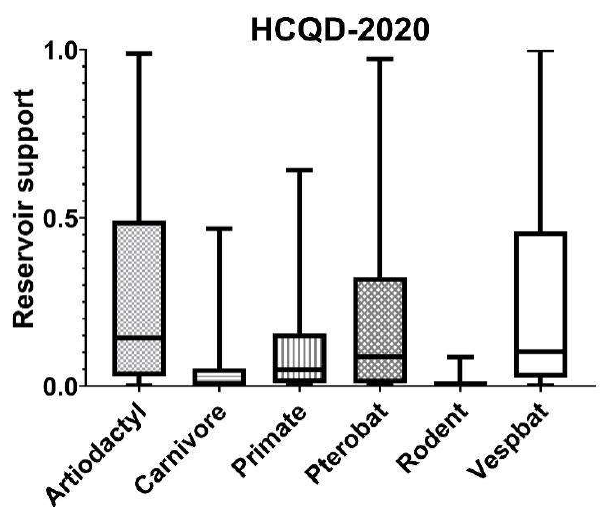
Figure 6. Potential host prediction of HCQD-2020 strain cross-infection in other orders of mammalians using viral host predictor tools. The boxes represent values between 25th and 75th percentiles of the probability scores while the whiskers show the min and max probability scores.